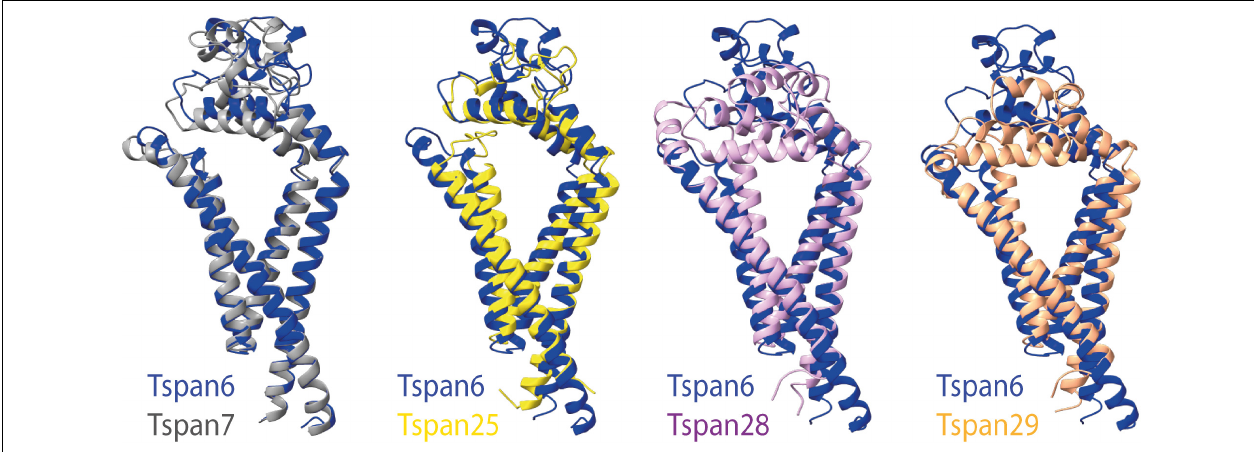
FIGURE 7 | Superposition of selected tetraspanin structures with the predicted structure of Tspan6. The left side shows the superposition of the structures of Tspan6 (blue) and Tspan7 (gray) predicted by AlphaFold; both tetraspanins are known to influence glutamatergic synapses. For comparison, the overlays of the structure of Tspan6 with already known resolved structures of tetraspanins are shown on the right (from left to right): overlay of Tspan6 with Tspan25 (yellow) (PDB model 6WVG) as well as with Tspan28 (pale pink) (PDB model 5TCX), and with Tspan29 (orange) (PDB model 6K4J).